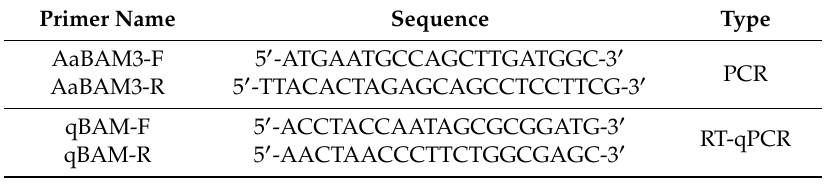
Figure 7. Alignment of the core sequence of part AcBAMs and their consensus sequences.